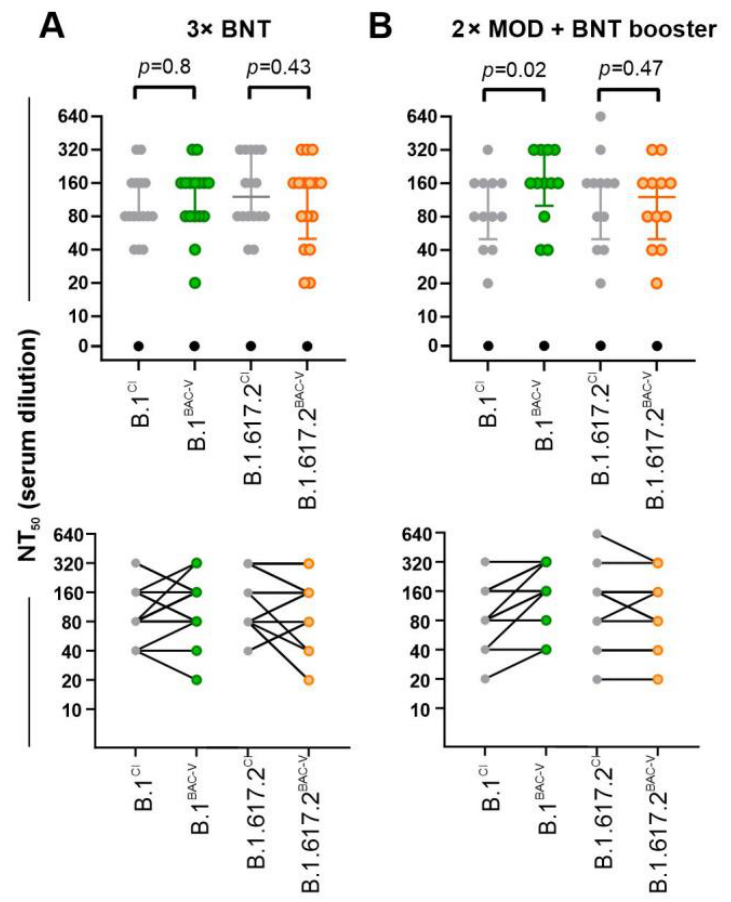
Figure 4. Antibody-mediated neutralization efficacy against recombinant and clinical SARS-CoV-2 variants. Graphs represent serum dilutions resulting in 50% neutralization (NT50) of B.1 CI (grey), B.1 BAC-V (green), B.1.617.2 CI (grey), and B.1.617.2 BAC-V (orange). Assays were performed using sera from individuals either ( A ). vaccinated and boosted with BNT162b2 (n = 16) (3x BNT) or ( B ). vaccinated with mRNA-1273 (MOD) and boosted with BNT162b2 (n = 12) (2x MOD + BNT booster). Negative control serum is indicated in black. Graphs represent data as median with interquartile range. One-Way ANOVA compared CI and BAC-V ( p -values are indicated above each data set) Bottom graphs indicate relations between NT 50 positive sera from ( A , B ). tested on BAC derived viruses (BAC-V) or corresponding clinical isolates (CI).